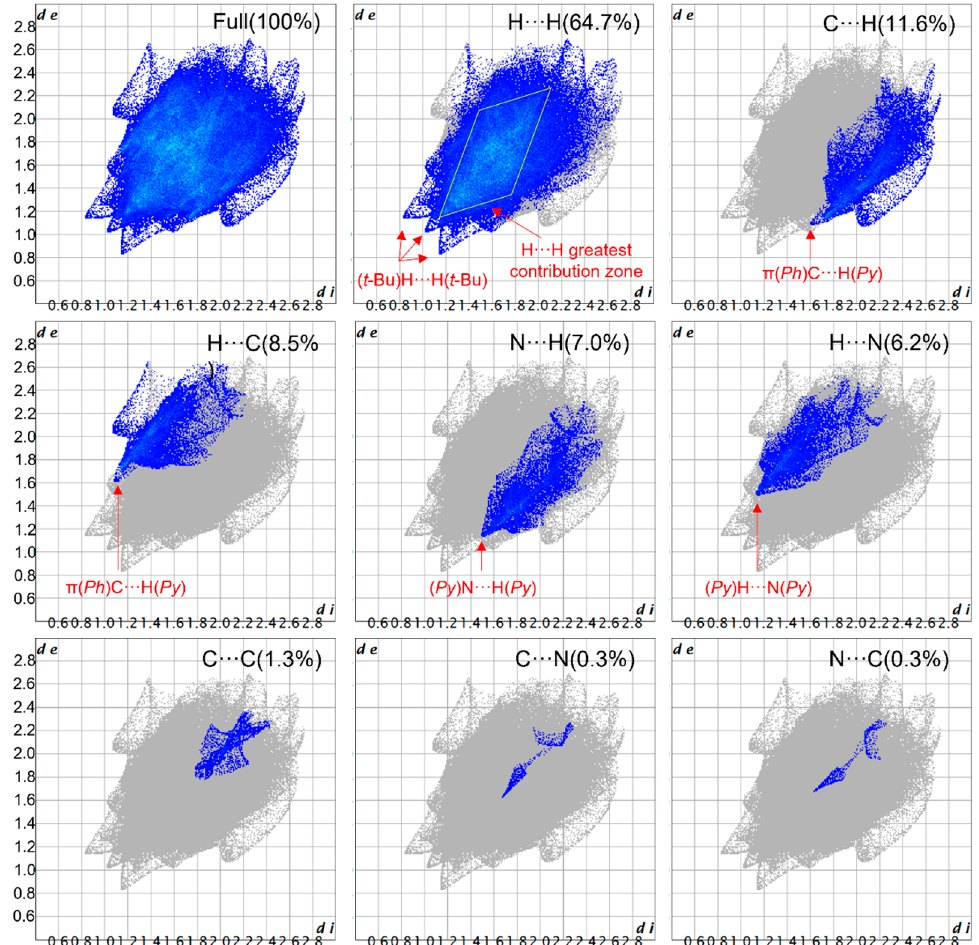
Figure 6. The 2D-fingerprint plots for all and outlined in H···H, C···H, H···C, N···H, H···N, C···C, C···N, and N···C intermolecular contacts through molecular HS in crystal 8 . In these A···B contacts, atom A is inside HS, while atom B is outside HS.